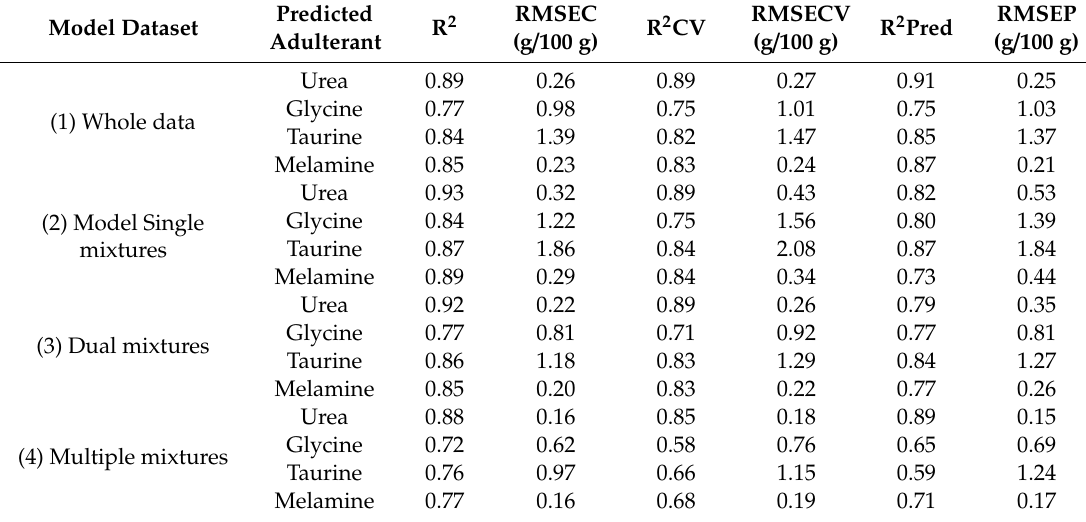
Table 3. PLSR models for adulterated whey protein powder samples scanned with the handheld spectrometer through the optical glass and analyzed at the spectral range of 950–1650 nm. Model